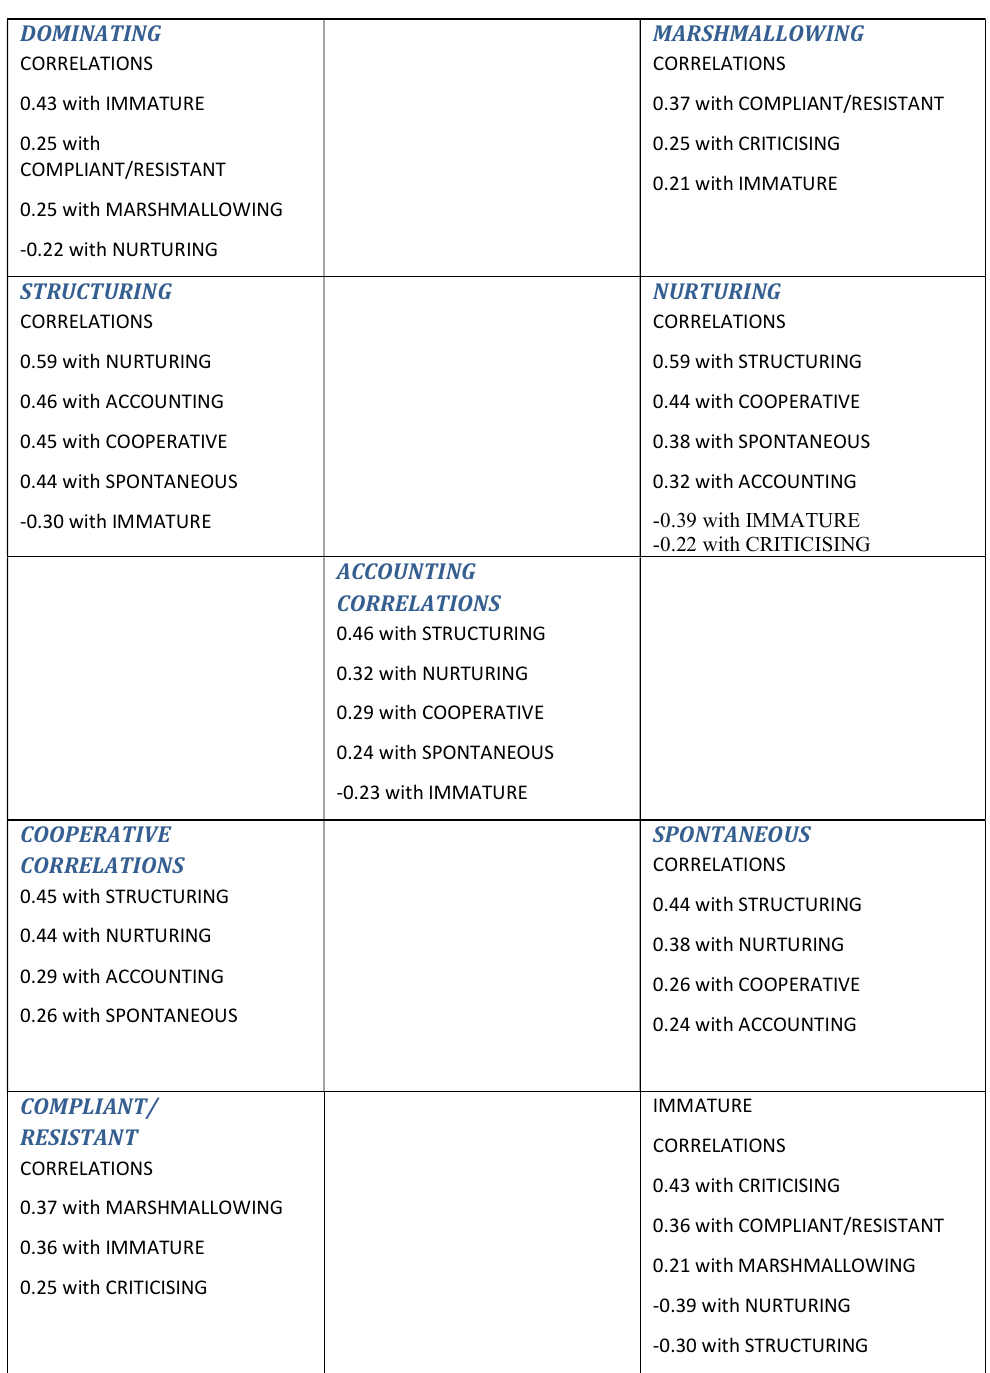
Table 4: Patterns of Inter-Mode Correlations using Pearson’s R DOMINATING CORRELATIONS 0.43 with IMMATURE 0.25 with COMPLIANT/RESISTANT 0.25 with MARSHMALLOWING -0.22 with